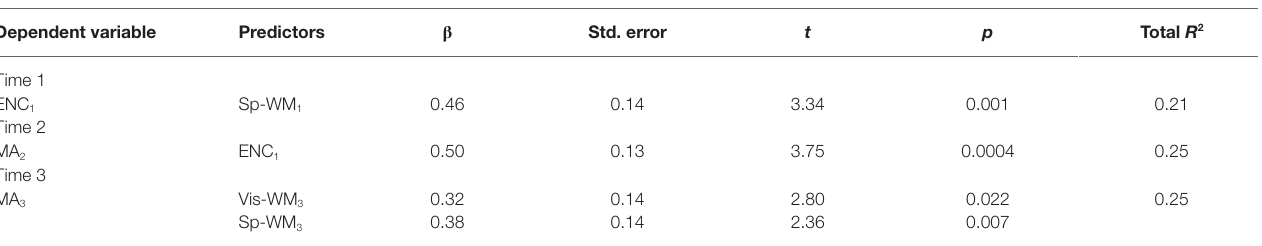
TABLE 4 | Best fit model for each